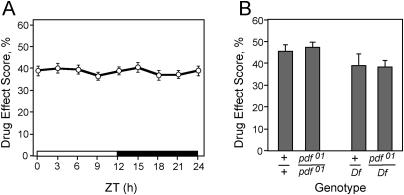
Cocaine Responses Are Not a Circadian Output and pdf Mutants Show Wild-Type Cocaine Sensitivity(A) Cocaine responses do not vary with the circadian clock. Control (EP1631) flies were raised under LD conditions and assayed for cocaine phenotypes in the crackometer at the indicated Zeitgeber (ZT) times. One-way ANOVA revealed no significant effect of time of day (F = 0.53, p = 0.82, n = 32).(B) Flies lacking the neuropeptide PDF (pdf01) display normal cocaine sensitivity. pdf01 homozygotes (pdf01/pdf01) and pdf01 hemizygotes (pdf01/Df) showed wild-type responses to cocaine in the crackometer. Individual pairwise comparisons using Student's t-tests revealed no significant differences between control (+/+ and +/Df) and pdf mutant genotypes (p = 0.69, p = 0.97, n = 6–8 experiments)